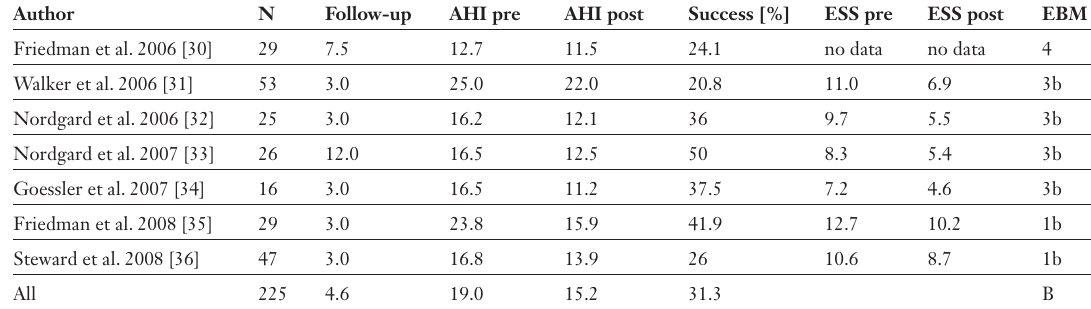
Efficacy of Pillar ® palatal implants in patients with OSA. Follow-up in months; AHI = apnoea-hypop- noea index; ESS = Epworth sleepiness scale; EBM = grading according to Oxford criteria [24].